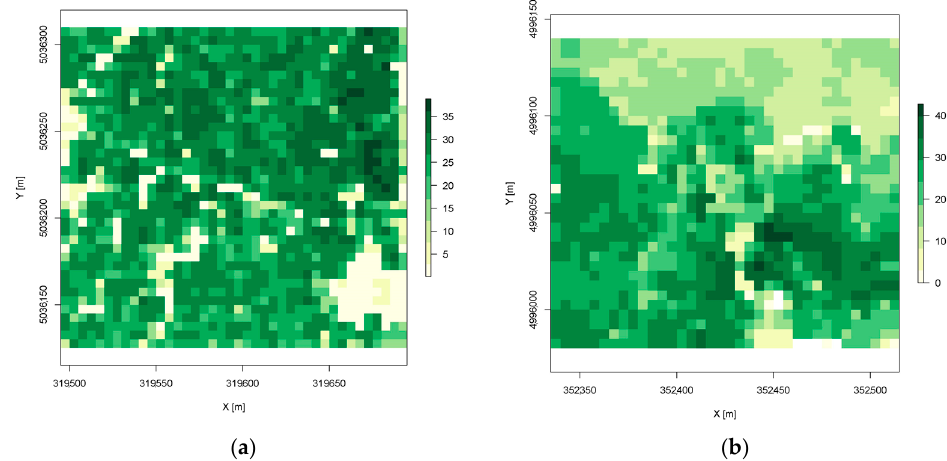
Figure 4. Canopy height model from airborne laser scanning ( a ) SMTM ( b ) SGTM. For computing above-ground tree volume, the logarithmic regression equation (Equation (1)) described in the work of [74] was used: